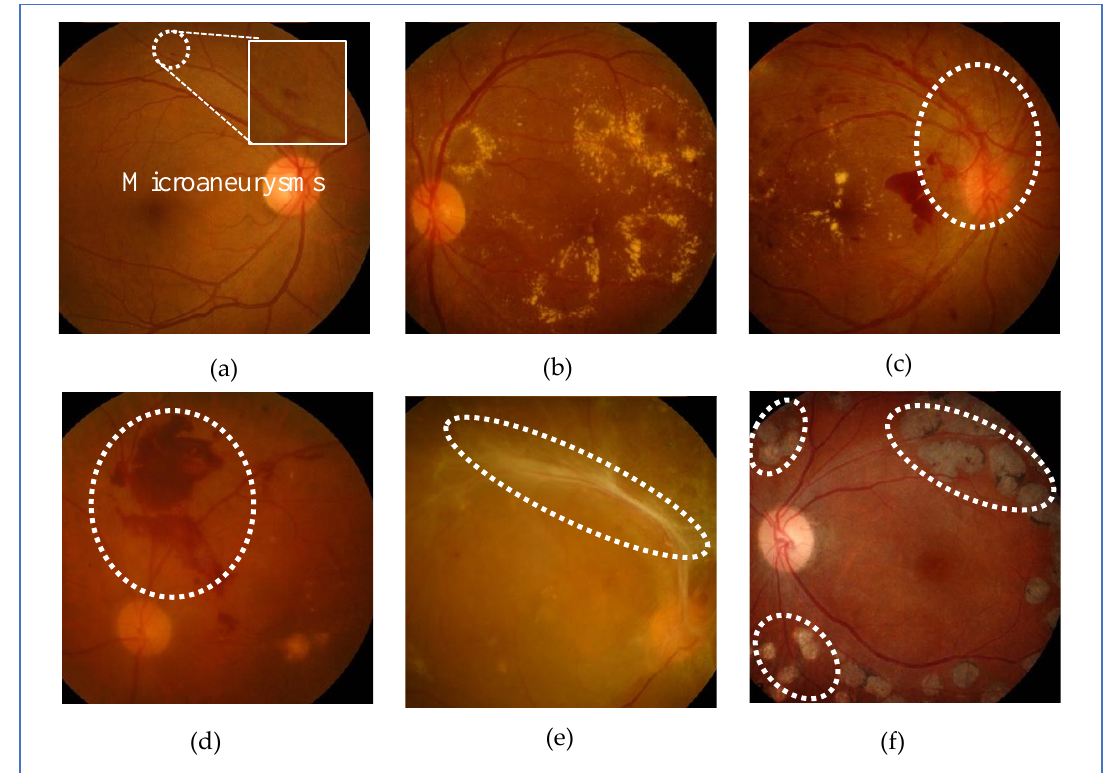
Figure 2. Representative pathological signs of DR: ( a ) mild non-proliferative diabetic retinopathy; ( b ) severe non-proliferative diabetic retinopathy; ( c ) neovascularization; ( d ) vitreous hemorrhages; ( e ) fibrous proliferations and ( f ) laser scars after treatment.